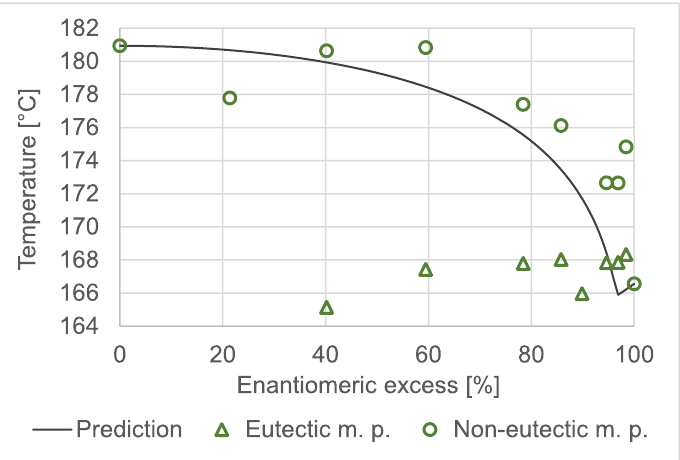
Figure 2. The chiral temperature composition phase diagram of the equimolar salt of scalemic mandelic acid and benzylamine.